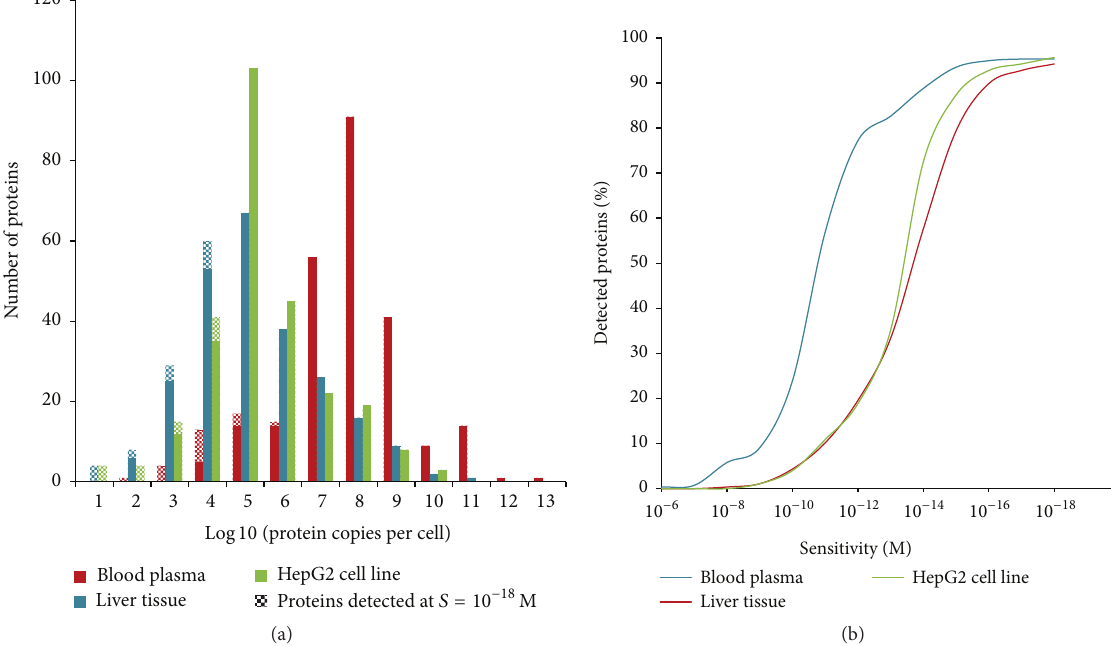
Figure 1: (a) Distribution of the copy numbers of master proteins of chromosome 18 normalized per single HepG2/liver cell or 1 𝜇 L of plasma. (b) Share as a function of the detected proteins (in % to the total number of chromosome 18-coded proteins) and the analytical sensitivity.